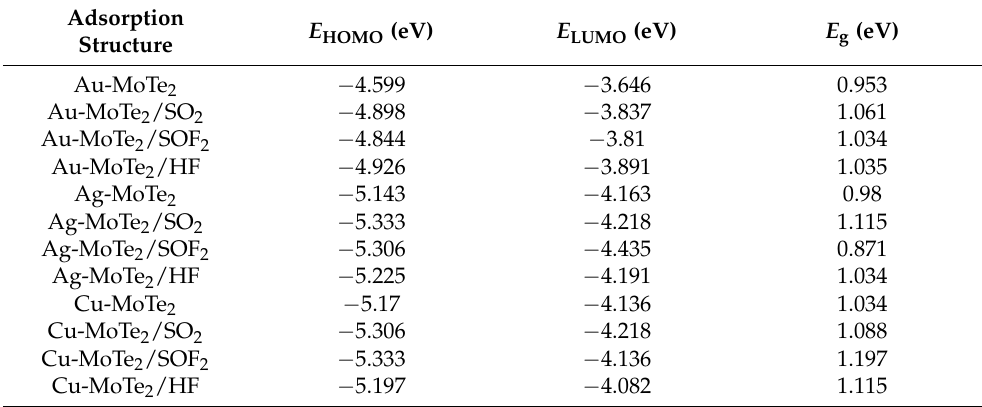
Table 3. Molecular orbits and energy gaps of before and after gas adsorption on TM-MoTe 2